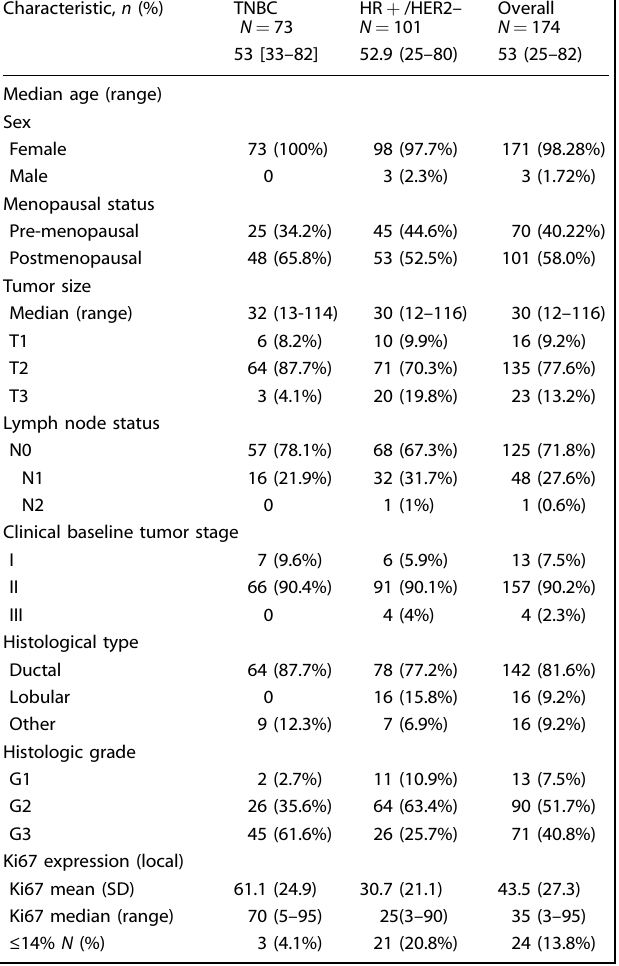
Table 1. Patient baseline characteristics.